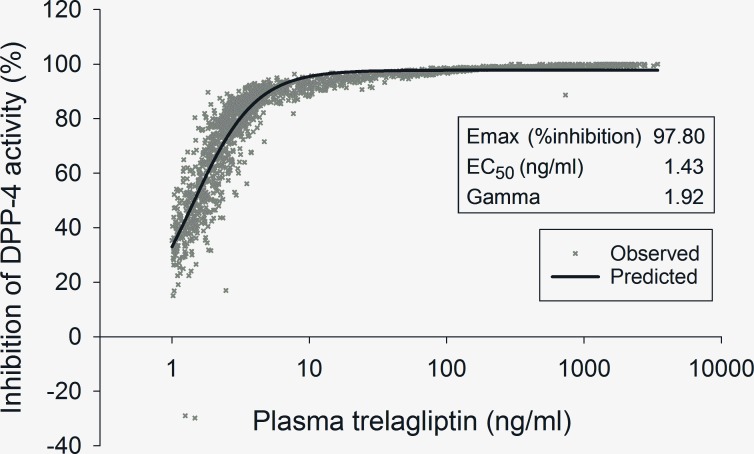
Relationship between trelagliptin pharmacokinetics and pharmacodynamics in T2DM patients in phase 2 dose-ranging study.Observed value plotted in “X” and predicted relationship between pharmacokinetics and pharmacodynamics by sigmoid Emax model is indicated by solid line. The plasma trelagliptin concentration estimated to yield 70% and 80% inhibition of human plasma DPP-4 activity was 2.31 ng/mL and 3.13 ng/mL, respectively.